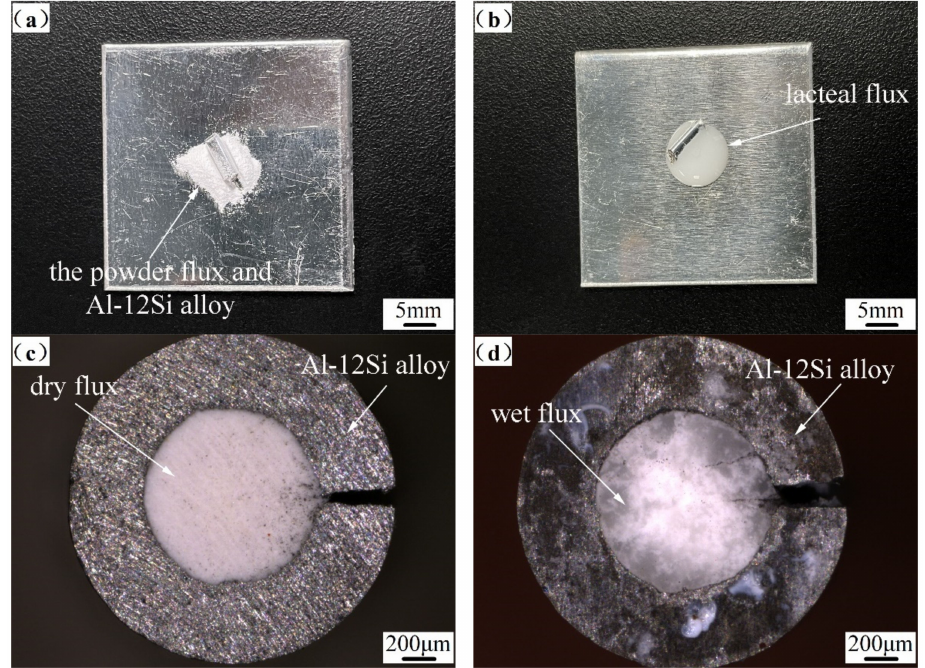
Figure 2. The macroscopic changes of powder flux and the SFC brazing filler metal before and after becoming damp: ( a ) Before the powder flux and Al-12Si alloy became damp; ( b ) After the powder flux and Al-12Si alloy was damp for 1 day; ( c ) Before the SFC brazing filler metal became damp; ( d ) After the SFC brazing filler metal was damp for 7